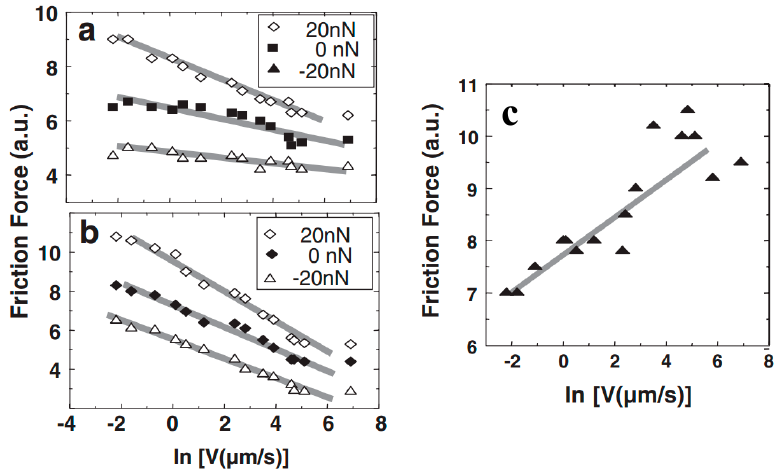
Figure 22. The sliding speed and RH dependence of friction forces at a single asperity contact between a silica microsphere and a hydrophilic silicon substrate. ( a ) Three-dimensional plot of the friction map at various RH and v conditions. The color from red to cyan denotes F t changing from large value to small value. ( b ) Friction force F t versus meniscus volume V m for the contact between the hydrophilic silicon surface and the silica microsphere ( F n = 2 µ N) moving at various v in RH < 50%. The inset picture showing the condensation of solid-like water at a single asperity contact. (d) F t versus V m for the high RH regime ( > 50%). The thick red line in ( c ) is the same trend line found for RH < 50% in ( b ). Colloids Interfaces 2019 , 3 , x FOR PEER REVIEW Reprinted from Ref. [91], Copyright 2017, with permission from ACS publications.